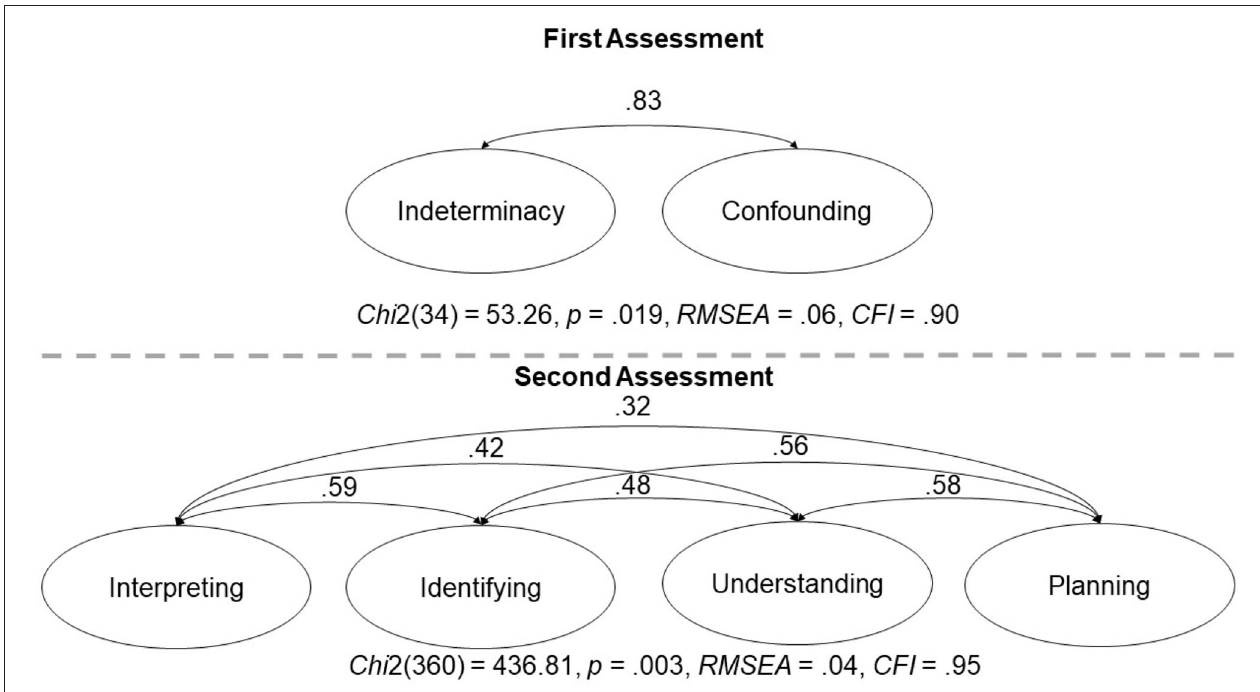
FIGURE 3 | Results from confirmatory factor analyses for the skills at the first (upper part) and second assessments (lower part), respectively. Indicator variables (individual items) omitted for visual clarity. All intercorrelations were significant at p < 0.001. When fixing the intercorrelation between inderterminacy and confounding to 1, the CFI deteriorated slightly to 0.89, and fixing any of the intercorrelations between the four CVS sub-skills from the second assessment to 1 substantially worsened model fits.